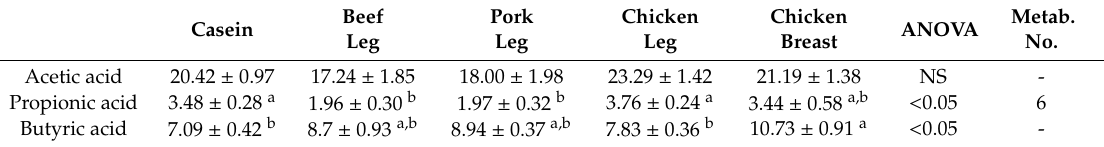
Table 1. E ff ects of dietary protein sources on short-chain fatty acid levels in the cecal content of mice.